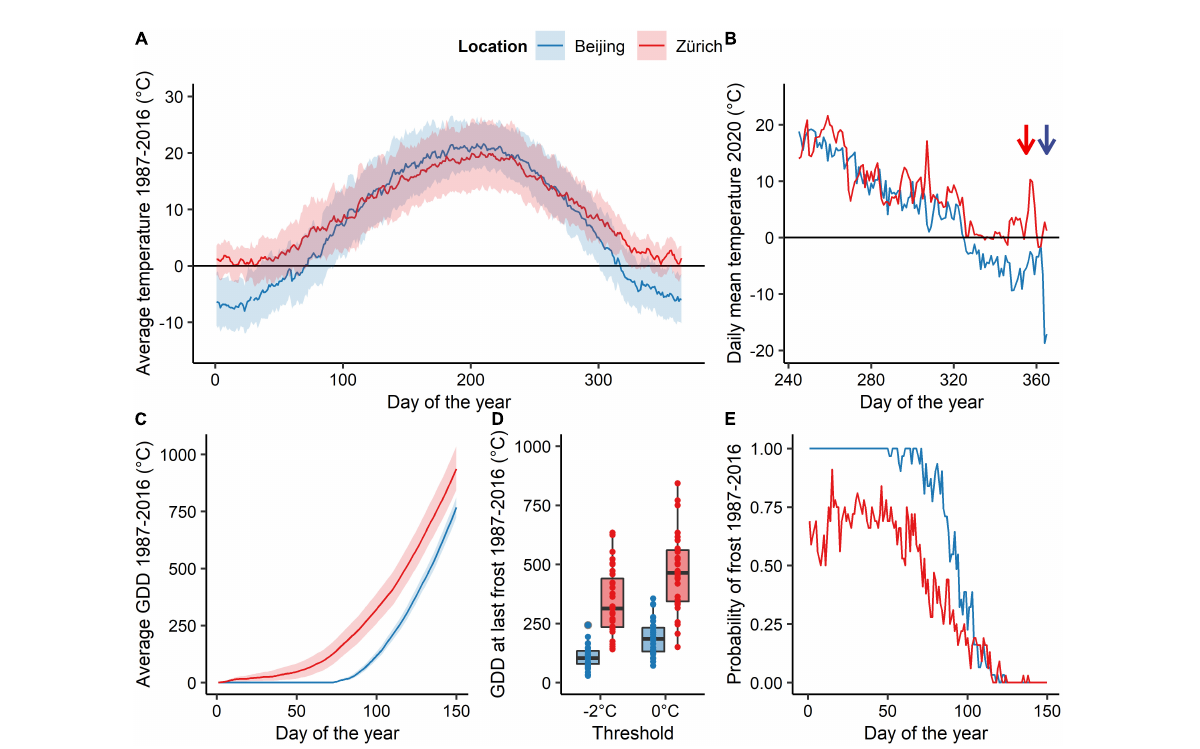
FIGURE1 Climatic characteristics of the study sites near Beijing and Zurich. Data derive from one weather station closely located to the sampling area (A) . Annual course of the average mean, minimum and maximum temperature, (B) daily average temperature of the autumn 2020 at the two study sites: The sampling dates (i.e., DoY = 350 for Zurich and DoY = 363 and 365 for Beijing) are indicated by arrows of the corresponding color. (C) Average GDD (mean ± se; threshold 0 ◦ C) accumulated during spring. (D) Accumulated growing degree days (threshold 0 ◦ C) at the last spring frost of the year (either below − 2 ◦ C or 0 ◦ C) during the period 1987-2016. (E) Long-term daily frost probability (i.e., daily minimum Temperatures < 0 ◦ C) during spring for the period